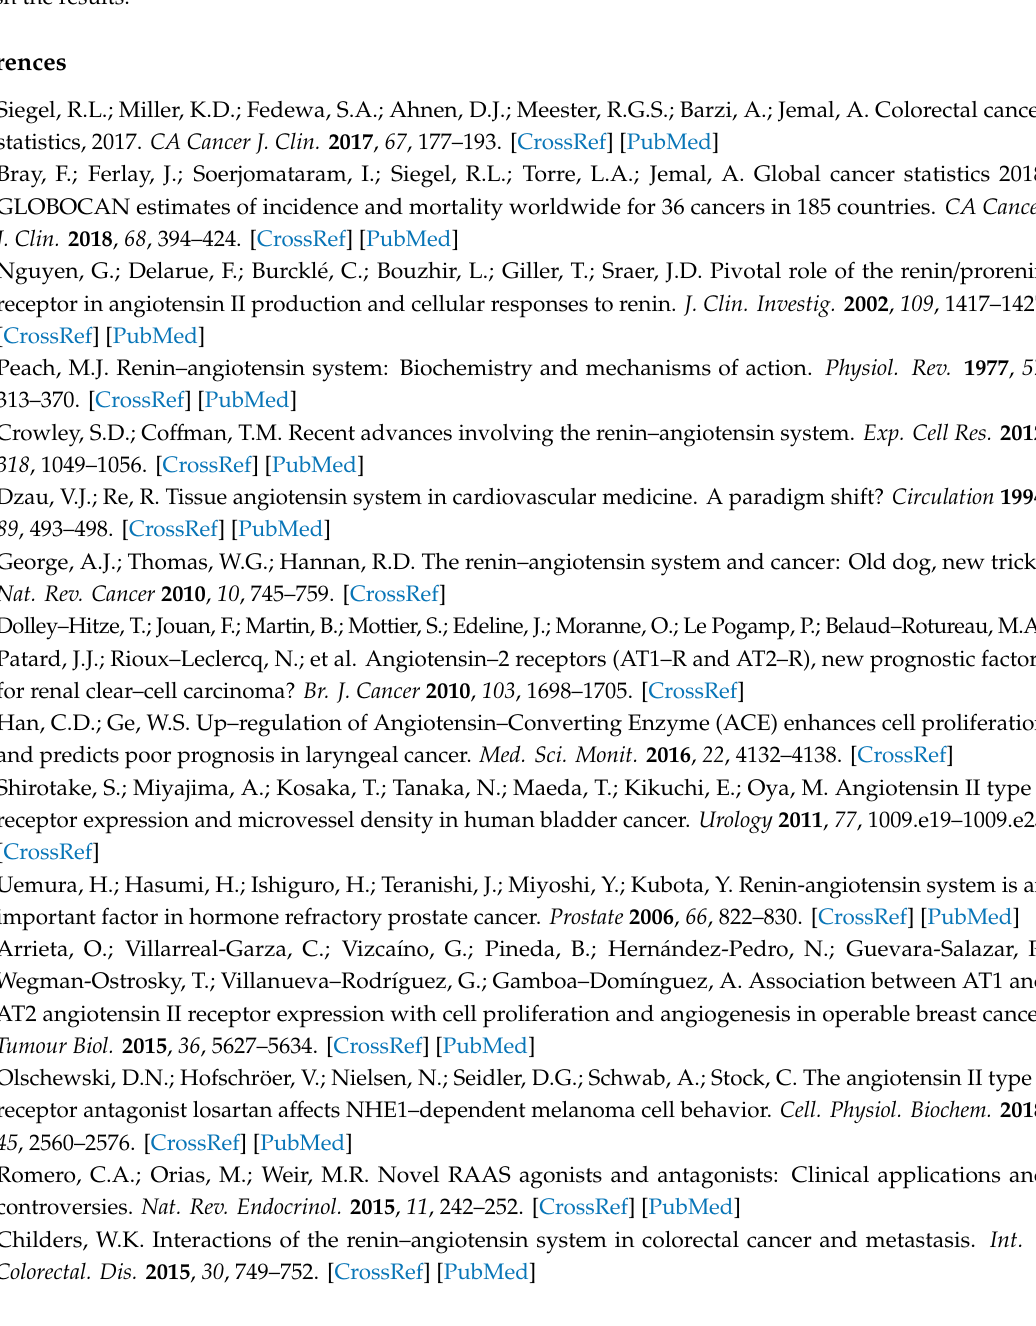
CRC. Figure S3: PRR knockdown in CRC cell lines for antibody’s specificity